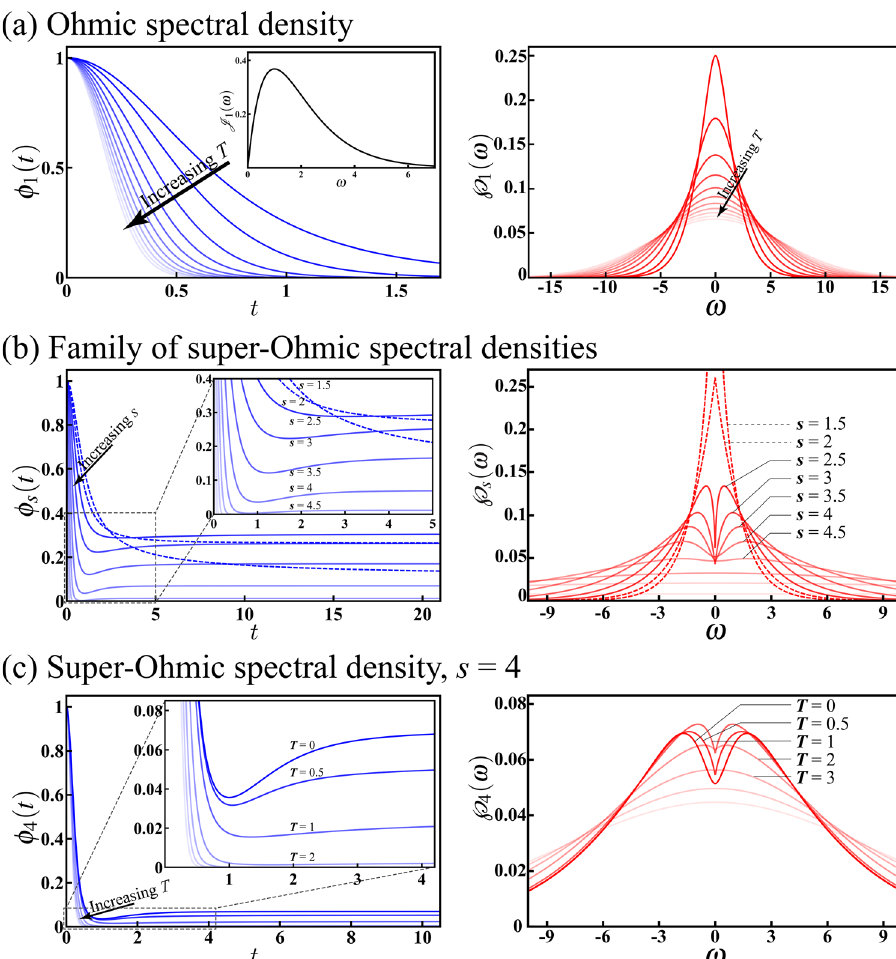
Figure 3. Dynamical behaviour (left panels) and CHER (right panels) of the spin-boson model with various spectral densities. ( a ) The Ohmic spectral density J 1 (ω) (inset) results in a Markovian pure dephasing as φ 1 ( t ) decreases monotonically. The increasing T reduces the coherence time, while the corresponding ℘ 1 (ω) broadens with increasing T . In these plots, we have assumed ω c (decreasing opacity). ( b ) The family of super-Ohmic spectral densities J s (ω) may result in either Markovian (dashed curves) or non-Markovian (solid curves) pure dephasing depending on the Ohmicity s , as indicated in the inset. Interestingly, this dynamical transition between Markovian and non-Markovian pure dephasing can also be understood in terms of the deformation of ℘ s (ω) . In these plots, we have assumed η and s ranging from 1.5 to 6.5 (decreasing opacity). ( c ) Ohmicity s of φ 4 ( t ) with increasing T from 0 to 5 (decreasing opacity) can be observed, reflecting the fact that the thermal fluctuations will wash out the non-Markovian memory effect. Meanwhile, the competition between the non- Markovian memory effect and the Markovian thermal fluctuations can be observed in terms of the uneven deformation of ℘ 4 (ω) with increasing T